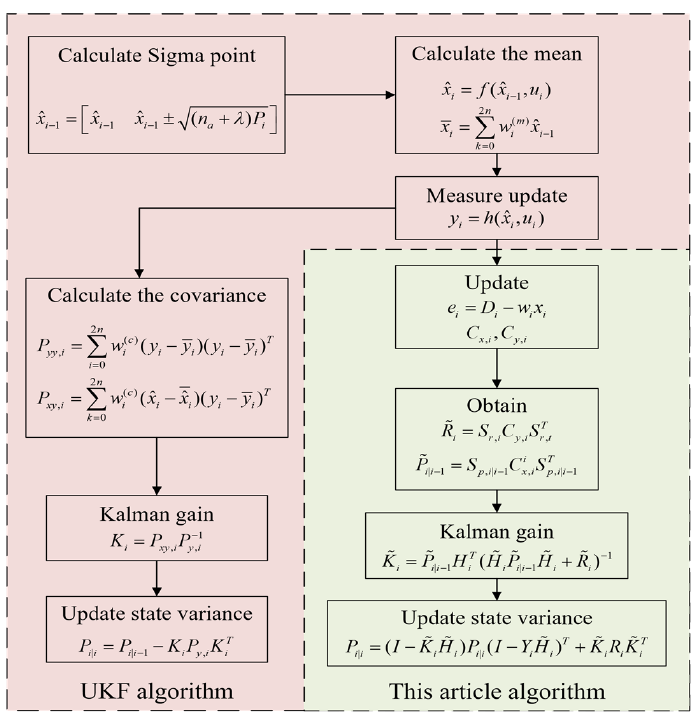
Figure 2. UKF algorithm derivation flowchart.